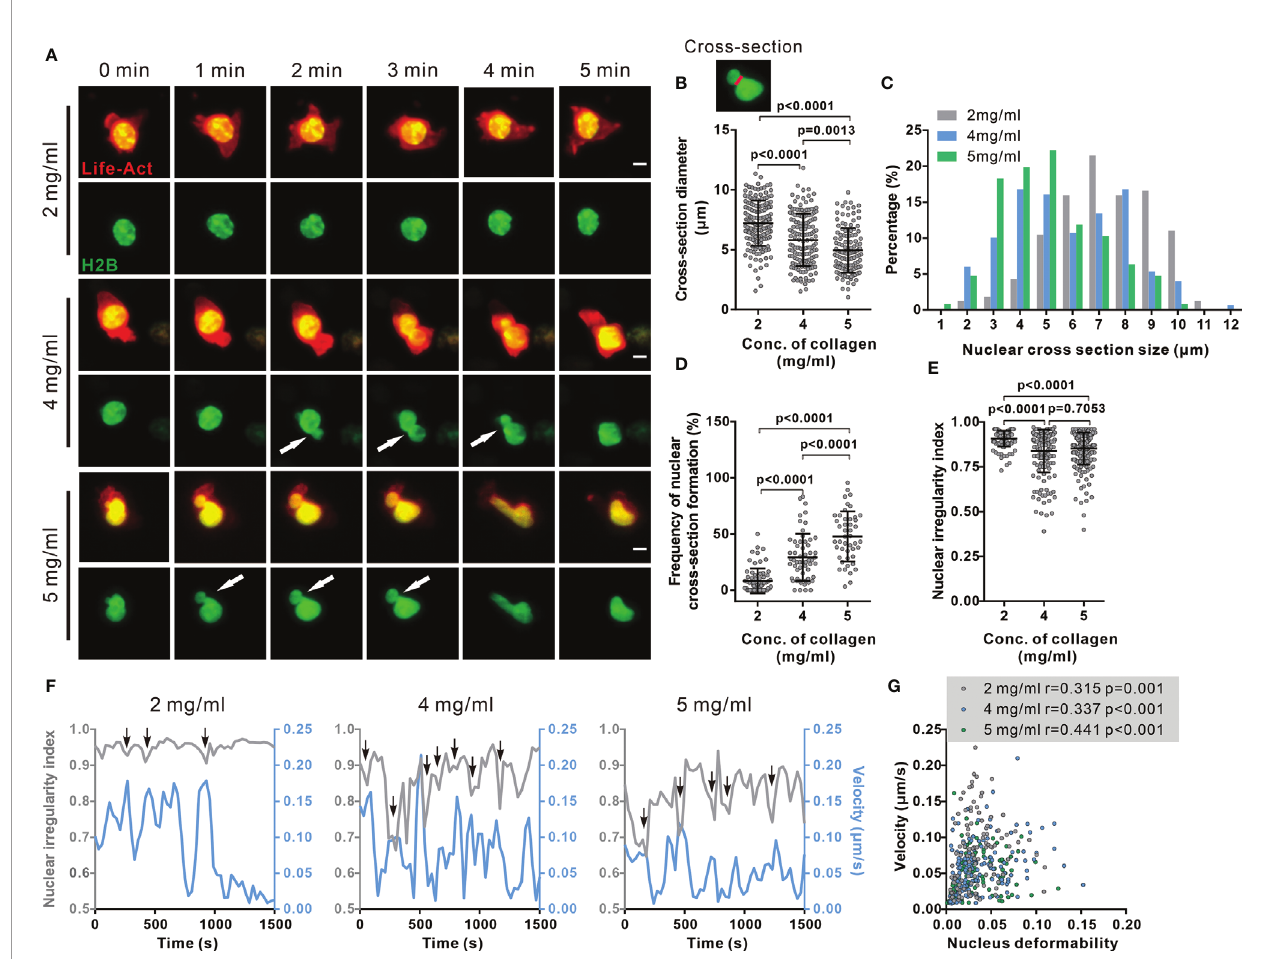
FIGURE 3 | Nuclear deformation is correlated with migration velocity in dense collagen matrices. (A – E) Nuclear deformation in CTLs is enhanced upon the increase in matrix density. CTLs transfected with Histone 2B-GFP (green) and LifeAct-mRuby (red) were embedded in collagen. Migration was visualized using light-sheet microscopy (20× objective) at 37°C every 30 sec for 30 min. Exemplary cells are shown in (A) . Cross-sections are pointed by the arrowheads. Scale bars are 5 µm. Quanti fi cation of cross-section diameter, their distribution and duration is shown in (B) (indicated as red-line in the inset), (C , D) . The nuclear irregularity index of the cells in (A – D) is shown in (E) . Results are presented as Mean ± SD for (B , D , E) . All results are from 3 donors. The Mann-Whitney test was used for statistical signi fi cance. (F , G) Migration velocity of CTLs is positively correlated with nuclear deformation. NII (sphericity) and velocity as function of time in exemplary cells are shown in (F) . Correlation between velocity and nuclear deformability is shown in (G) . One dot represents one cell. Correlation coef fi cient r is analyzed with Spearman ’ s correlation. All results are from 3